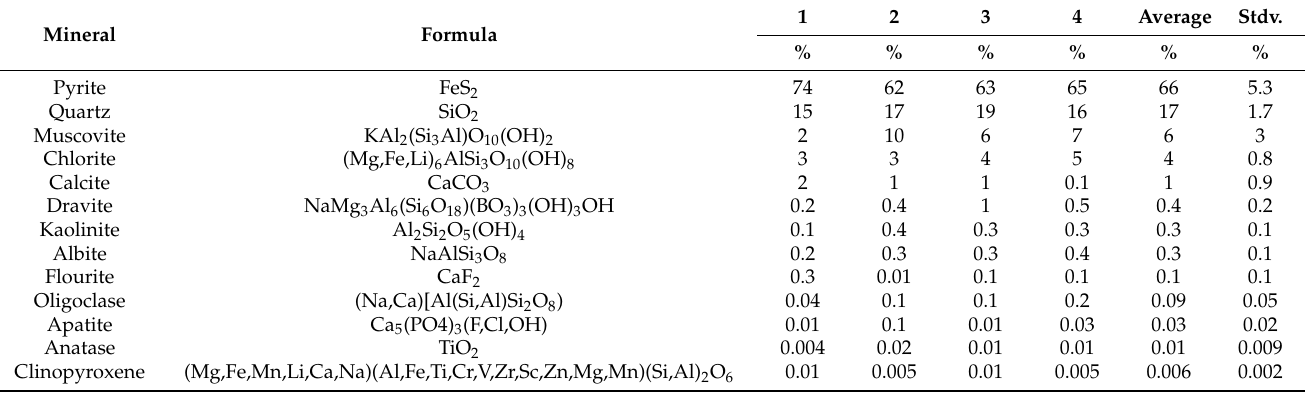
Table 2. Quantitative mineralogical composition of pyritic waste rock determined by quantitative automated mineralogy (QEMSCAN) based on a total of 38 waste rock cross-sections mounted onto four thin sections. Mineral Formula Pyrite FeS